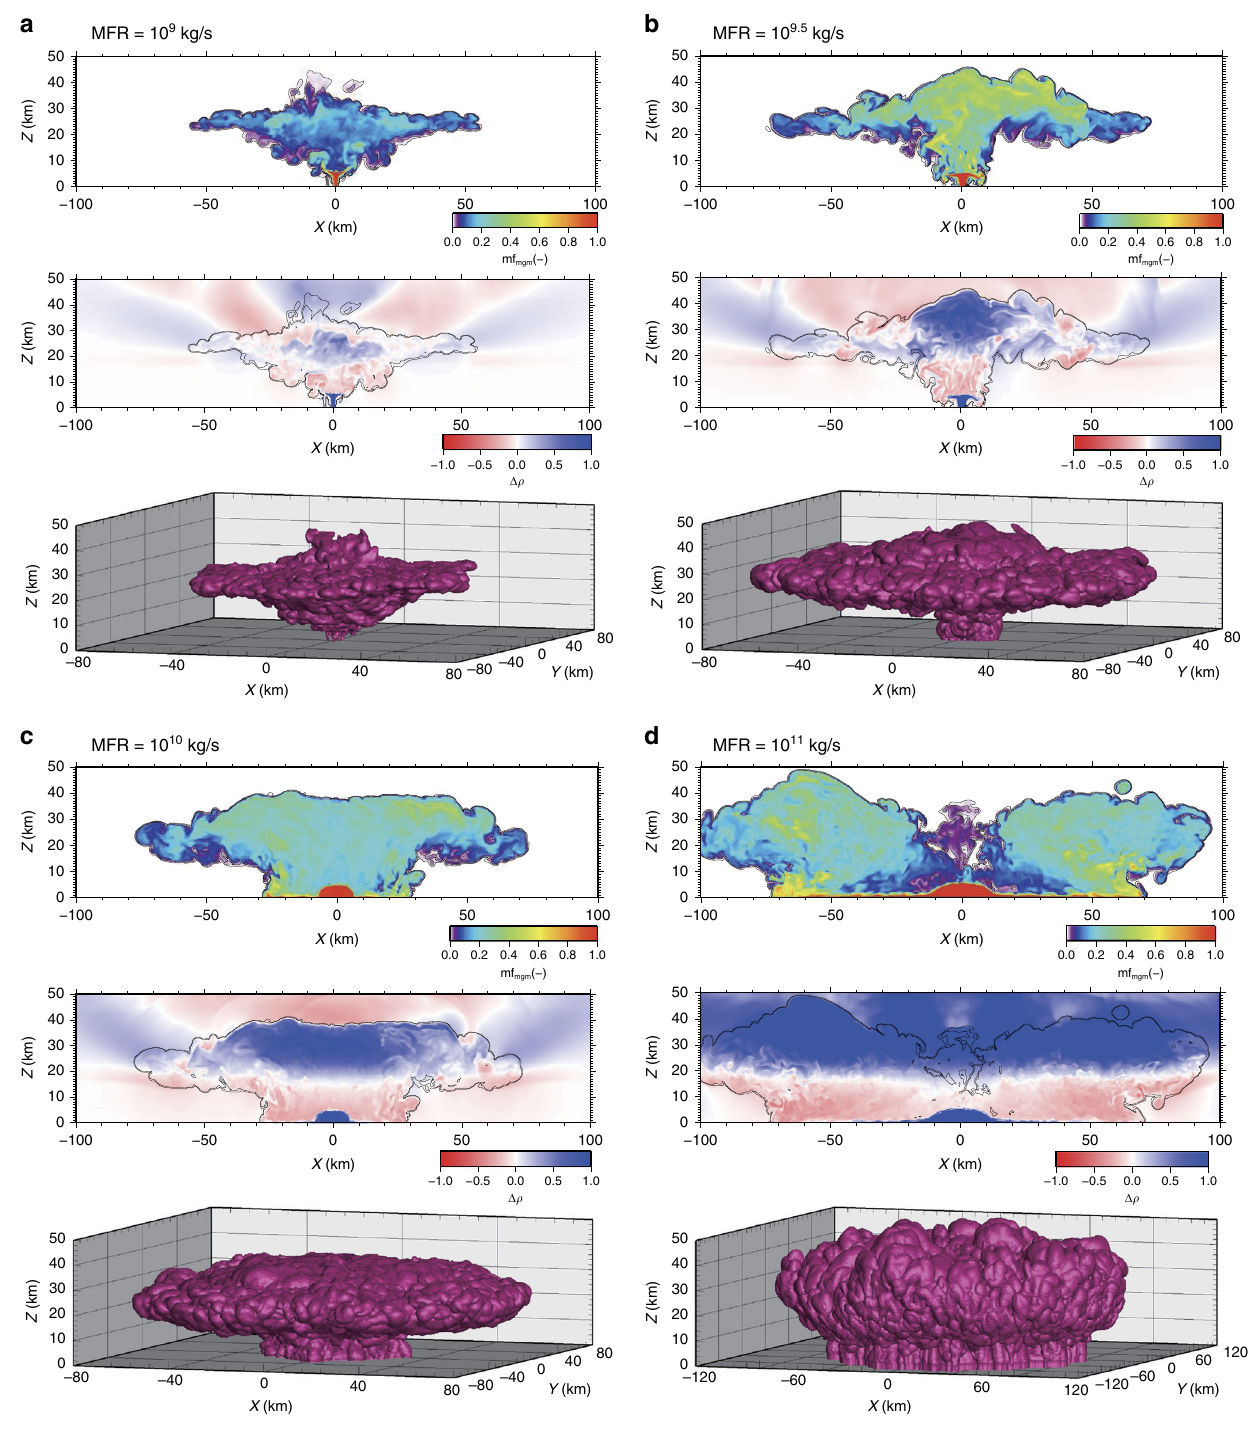
Fig. 1 Simulation results for the plumes with different MFRs. a 10 9 kg/s, b 10 9.5 kg/s, c 10 10 kg/s, d 10 11 kg/s. The fi gures show snapshots at t = 800 s after the eruption initiation: vertical cross-sections of the mass fraction of the erupted mixture is 0.01 ( a – d , upper panels); density difference relative to the atmospheric density ( a – d , middle panels); three-dimensional isosurface where the mass fraction of the erupted mixture is 0.01 ( a – d , lower